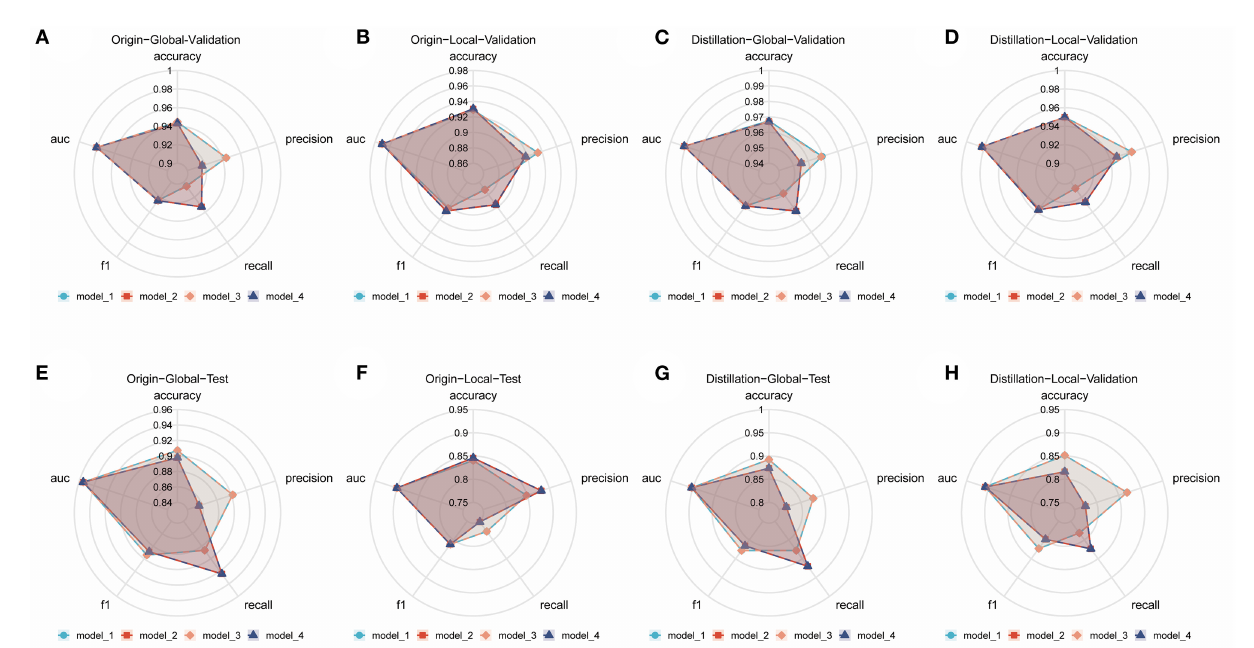
FIGURE1 Comparison of different ensemble DL models in each internal validation dataset and external test dataset. (A) Comparative radar plot of different ensemble DL models in the origin-global internal validation dataset. (B) Comparative radar plot of different ensemble DL models in the origin-local internal validation dataset. (C) Comparative radar plot of different ensemble DL models in the distillation-global internal validation dataset. (D) Comparative radar plot of different ensemble DL models in the distillation-local internal validation dataset. (E–H) show the comparison of the performance of the models validated in the above dataset in the external test dataset (Model 1, model 2, model 3, and model 4 represent the models with the top 5 AUCs in each dataset using different methods of integration). Model 1: the prediction results of the 5 sub-models are directly averaged with a classification threshold of 0.5. Model 2: the prediction results of the five sub-models are directly averaged with a classification threshold of the optimal cut-off value in the training set. Model 3: the prediction results of the 5 sub-models are weighted and averaged with a classification threshold of 0.5. Model 4: the prediction results of the 5 sub-models are weighted and averaged with a classification threshold of the optimal cut-off value in the training